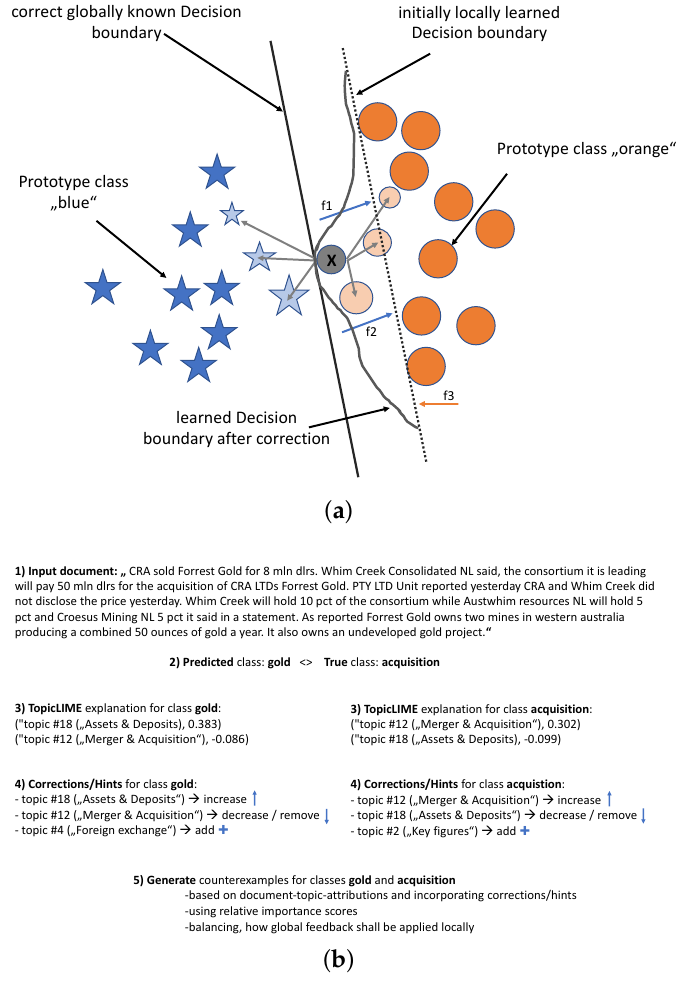
Figure 4. ( a ) Conceptualization of SemanticPush: The grey query instance in the middle is predicted as class “blue”, but should be “orange” instead according to ground truth. Local explanation fea- tures f1 and f2 are features used by the classifier locally to assign the query instance to class “blue”. According to expert knowledge, those features push the learned local decision boundary too far towards the class “orange”. Feature f3 also constitutes expert knowledge as it is, among others, significantly used globally by the classifier to assign instances to class “orange”. SemanticPush incorporates this information by generating new instances (shown in light color) for both classes and eventually weighs them by their distance to the query instance. The degree of locality of ap- plying the expert knowledge to the query instance is controlled by the hyperparameter λ . Sam- pling new instances only based on global expert knowledge might result in prototypical instances (located in dense regions) which might not lead to great benefit for the classifier. ( b ) An exemplary application of SemanticPush to document ID 9 of the Reuters R 52